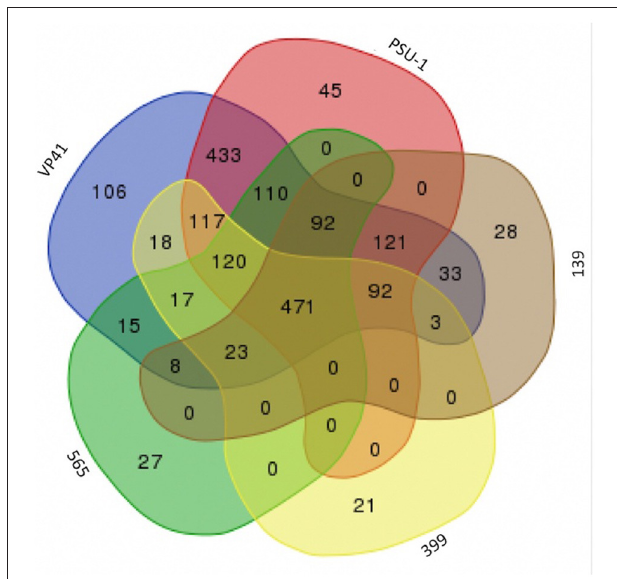
FIGURE 3 | Venn diagram between genome of Chilean autochthonous O. oeni isolates compared with two reference strains VP41 and PSU-1.